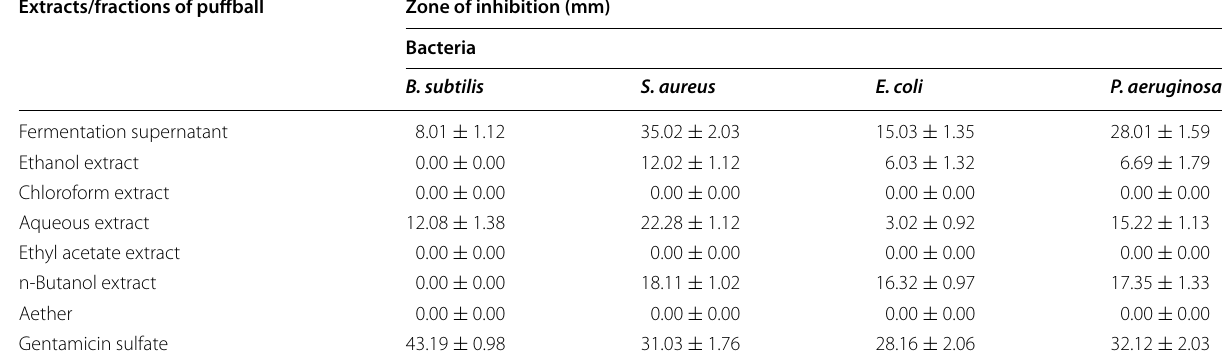
SD of three repeats ±